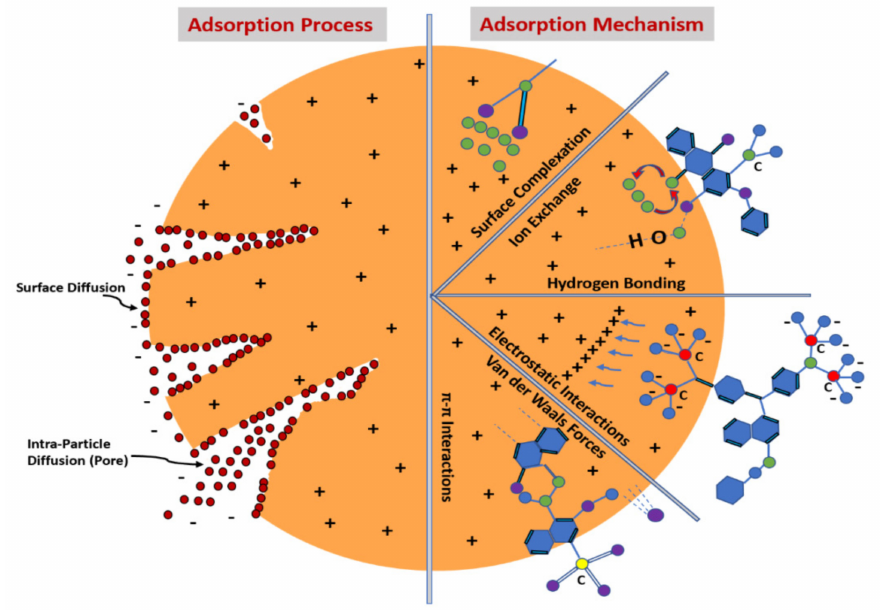
Figure 14. Schematic representation of the adsorption process and its mechanism for the adsorption of pollutants [Reprinted with permission from ref. [169], Hamad, H.N.; Idrus, S. Recent Developments in the Application of Bio-Waste-Derived Adsorbents for the Removal of Methylene Blue from Wastewater: A Review. Polymers 2022 , 14 , 783. https://doi.org/10.3390/polym14040783], Copyright ©